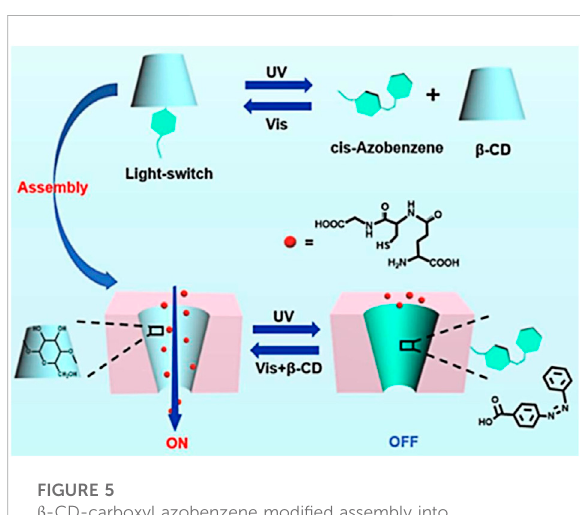
FIGURE 5 β -CD-carboxyl azobenzene modi fi ed assembly